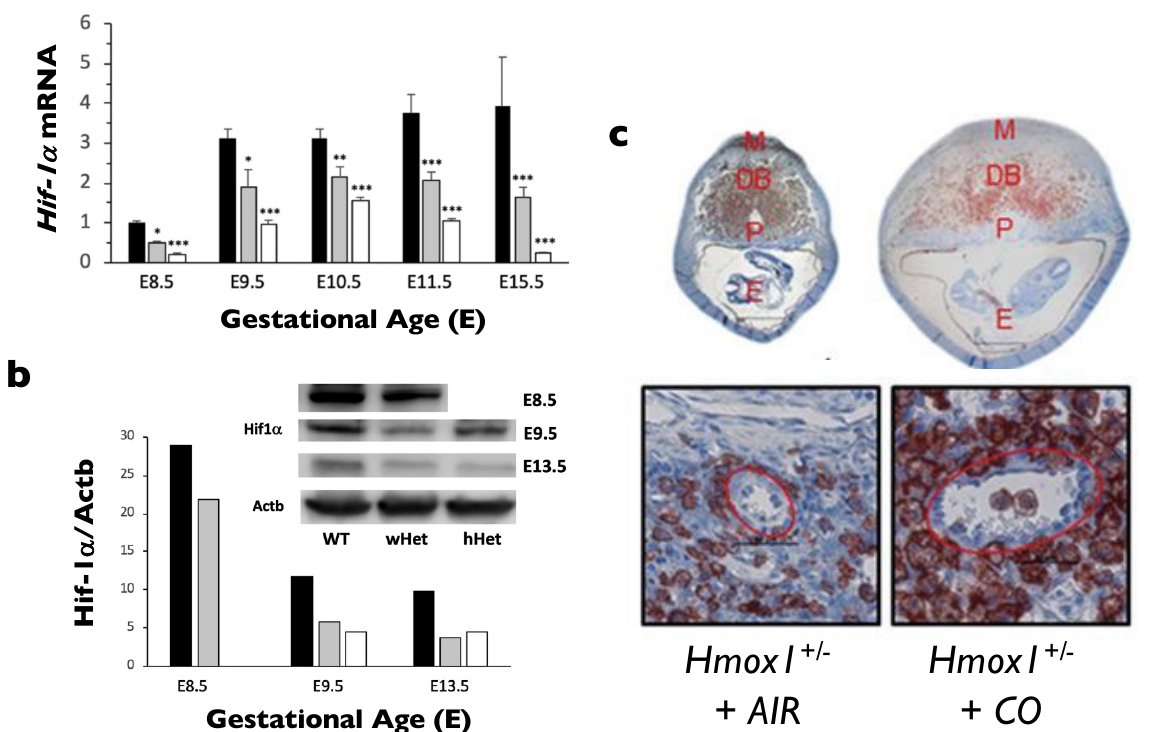
Figure 3. Relationship between HO-1 and HIF-1 α . ( a ) HIF-1 α mRNA expression was measured in placentas at various gestational ages harvested from WT pregnancies (WT, black bars, n = 3 at each age), HO-1 Het pregnancies with WT fetuses (wHet, gray bars, n = 3 at each age) or HO-1 Het fetuses (hHet, white bars, n = 3 at each age). HIF-1 α expression was normalized to Gapdh and Actb levels. ( b ) HIF-1 α protein levels in placentas at various gestational ages harvested from HO-1 Het pregnancies with WT fetuses (wHet, gray bars) or HO-1 Het fetuses (hHet, white bars) compared with placentas from WT pregnancies (black bars) are shown by Western blots. HIF-1 α expression was normalized to Actb levels. Due to the extremely small size of fetuses at E8.5, standard genotyping could not be performed. Therefore, Hmox1 mRNA levels were used to differentiate wHet and hHet placentas for mRNA studies, but this was not feasible for Western blots. * p < 0.05; ** p < 0.01; *** p < 0.005. Reprinted from Zhao H, et al, Placenta 2020 , 99 , 108-116, no permission required. ( c ) Administration of 50 ppm CO to pregnant HO-1 Het mice ( Hmox1 +/- + CO) at E3 to E8 increased the abundance of uNK cells (samples collected at E10) and improved spiral artery remodeling compared with placentas from pregnant HO-1 Het mice exposed to ambient air ( Hmox1 +/- + AIR). DBA lectin staining of mid-sagitally cut whole implantation sites (top panel, DB, decidua basalis; E, embryo cavity; M, MLAP; P, placenta) and representative images of spiral arteries at the fetomaternal interface (400X ; scale bar: 50 µm). Reprinted with permission From Linzke N, et al, Hypertension 2014 , 63 , 580-588.